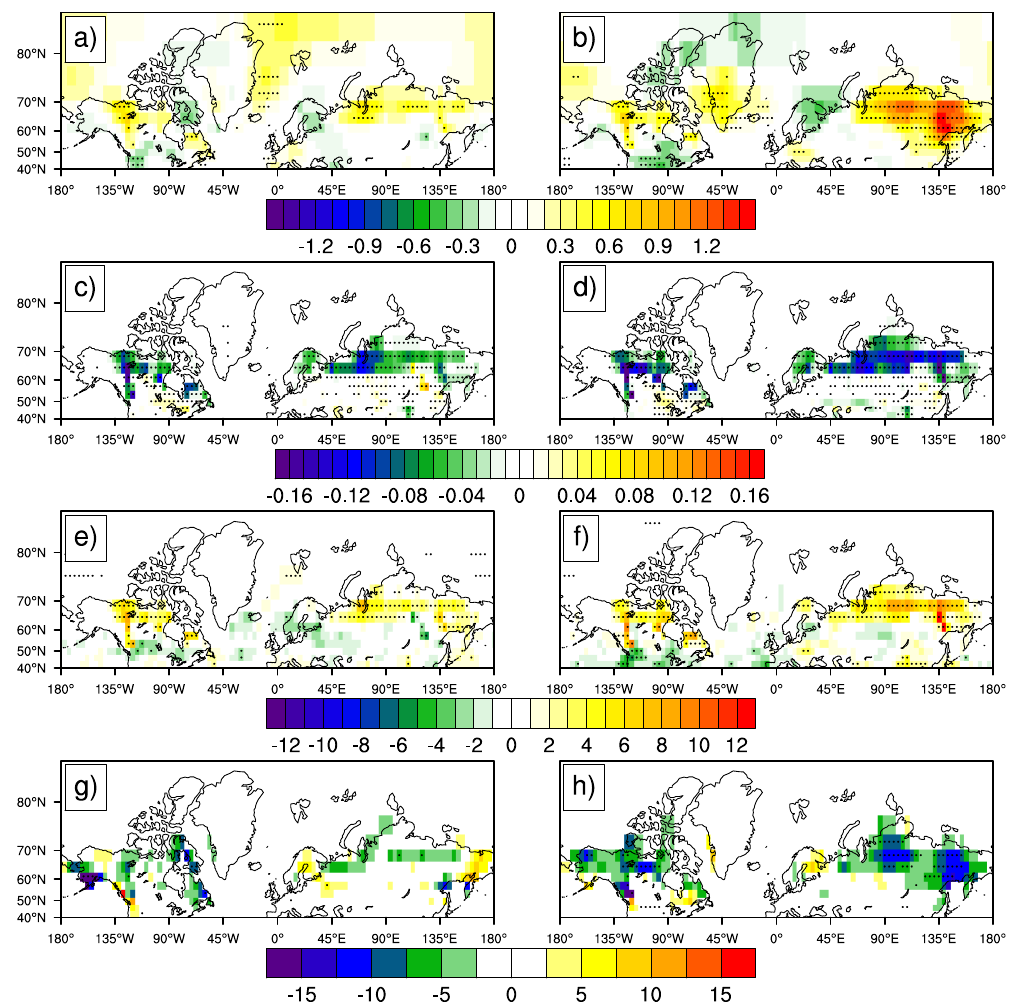
Fig. 2. Mean spring climate values for 1V w (left column) and 1V s (right column): air-temperature in ◦ C (a) and (b) , surface albedo (c) and (d) , net surface solar radiation in Wm − 2 (e) and (f) , snow water equivalent in mm (g) and (h) . The black dots indicate significant values with 0.05 level of